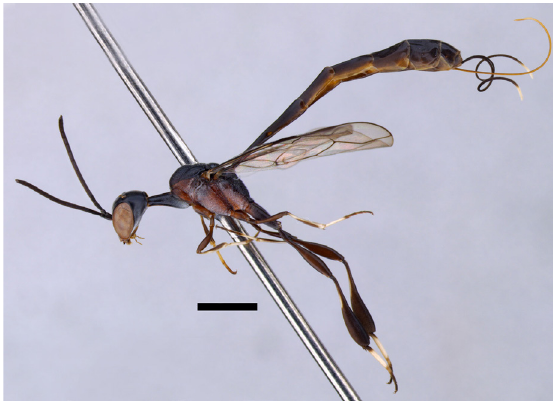
Figure 1. Gasteruption bispinosum Kieffer, 1904, habitus. Scale bar = 2 mm.